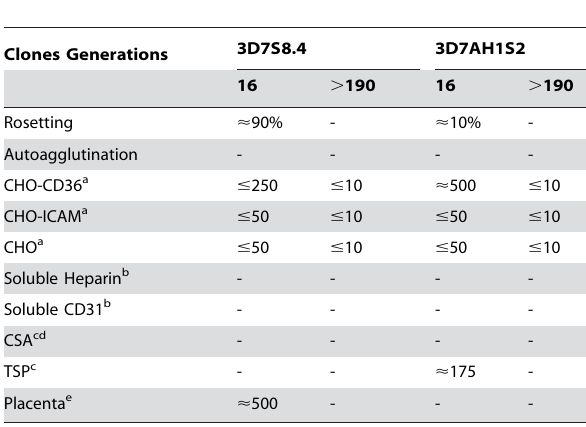
Table 1. Adhesion profile of 3D7AH1S2 and 3D7S8.4 at early and late generations